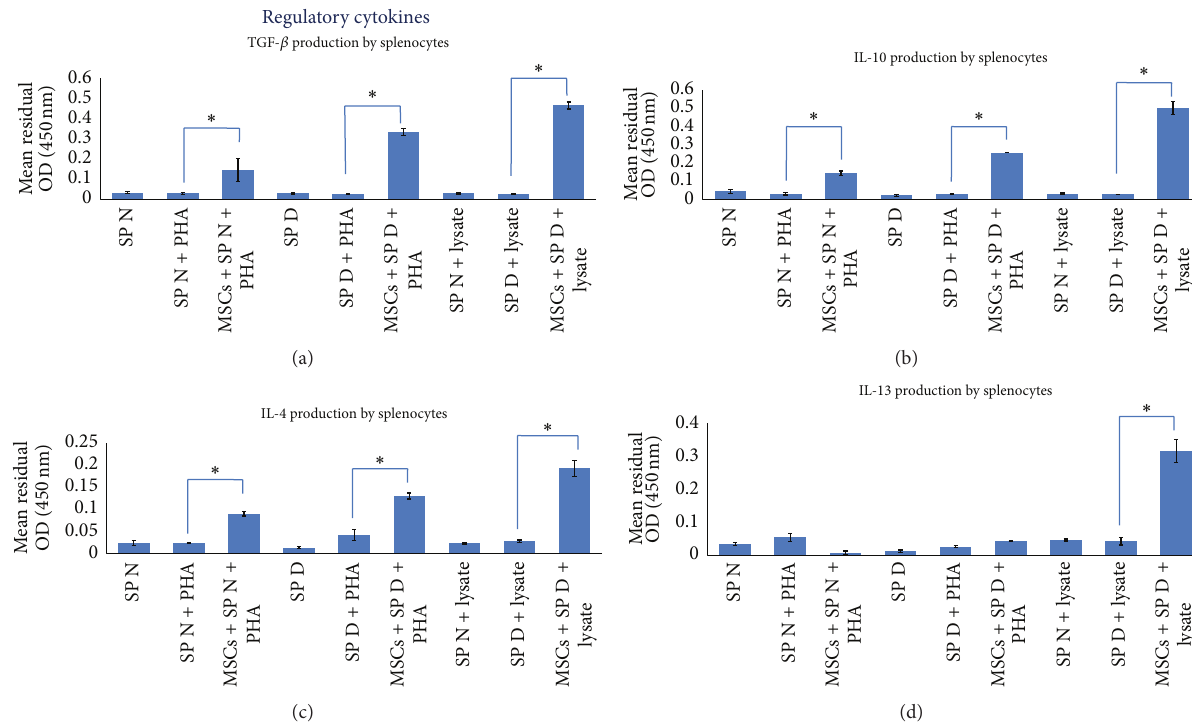
Figure 5: The immunomodulatory effects of AT-MSCs at passage 3 on regulatory cytokines produced by splenocytes. AT-MSCs in coculture with islet, or PHA, stimulated splenocytes increased TGF- 𝛽 , IL-10, IL-4, and IL-13 production by splenocytes ((a), (b), (c), and (d)). Background absorbance of cytokines produced by AT-MCSs was subtracted. Therefore, the representative results show splenocytes related cytokines pattern. Data presented the mean ± SD of five independent experiments. ∗ indicates significant difference between groups ( 𝑃 < 0.05 ). SP N: normal splenocytes; SP D: diabetic splenocytes; PHA: phytohemagglutinin; lysate: pancreatic islet cells